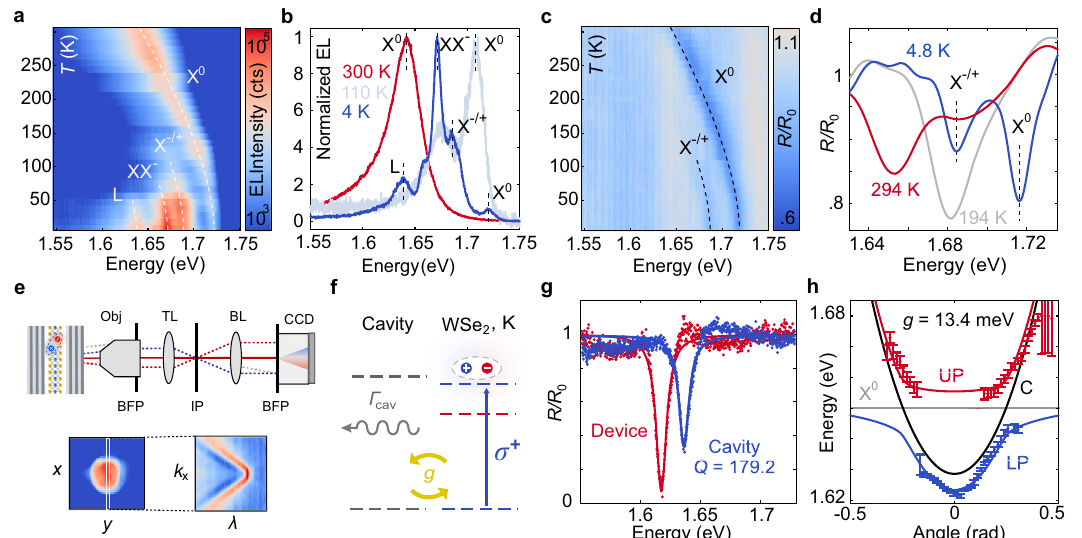
Fig. 2 | Excitonic light emission and strong coupling regime. a , b Temperature dependenceof EL at V pp sq =13 : 5V and f =9 MHz. X 0 : neutral exciton,X − /+ : charged exciton. XX − : negatively charged biexciton. L: bound exciton. Dashed lines are guides to the eye indicating the different exciton energies. c , d Temperature dependence of re fl ectance before cavity growth. R 0 : background re fl ectance taken on the heterostructure without WSe 2 . e Schematics of the setup used for backfocalplanespectroscopy.BFPbackfocalplane,TLtubelens,IPimageplane, BL Bertrand lens. The surface plots correspond to the re fl ected light intensity measured at the image plane and back focal plane. f Physical model for exciton – photon coupling. A cavity mode with decay rate Γ cav interacts with